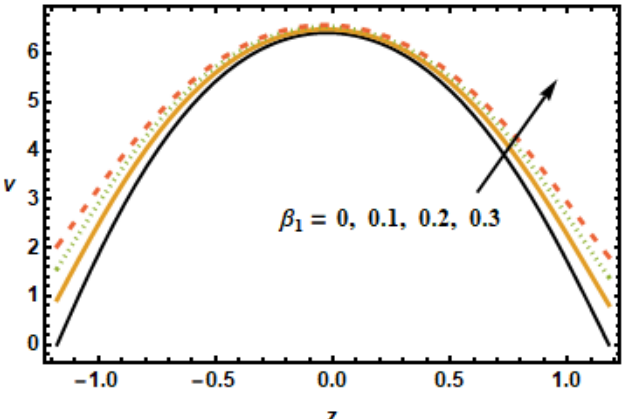
Figure 12. Dependence of v on secondary slip β 1 .